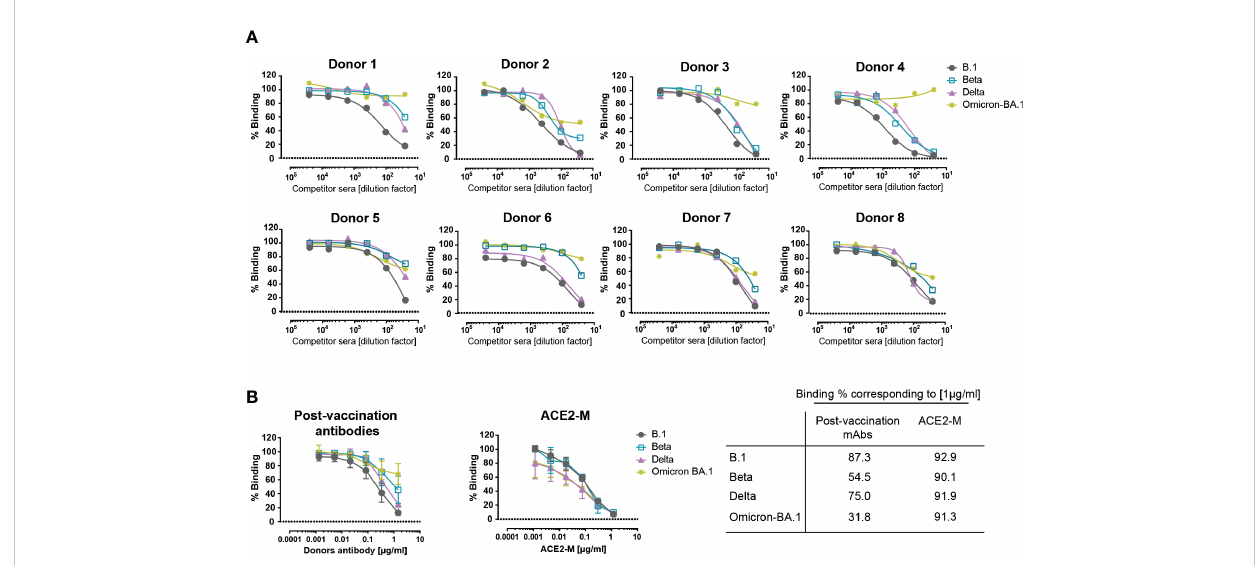
FIGURE 3 Competitive binding of antibodies in the sera of vaccinated donors and ACE2-M to various spike proteins. (A) Similar competition ELISA assay to the one described in Figure 1A was performed with sera from 8 healthy vaccinated individuals. Each serum sample was diluted in a range of 1/25 to 1/ 25600 and tested against His-tagged ACE2 for binding to SARS-CoV-2 B.1, Beta, Delta, and Omicron – BA.1 S-protein variants. (B) SARS-CoV-2 antibodies were quanti fi ed in donor sera using the Euroimmun ELISA. Equal amounts of antibody or ACE2-M were diluted in SARS-CoV-2 negative serum and tested in a competition ELISA for their ability to compete with wild-type ACE2-His for S-protein binding. The table summarizes the percentage binding achieved by a protein concentration of